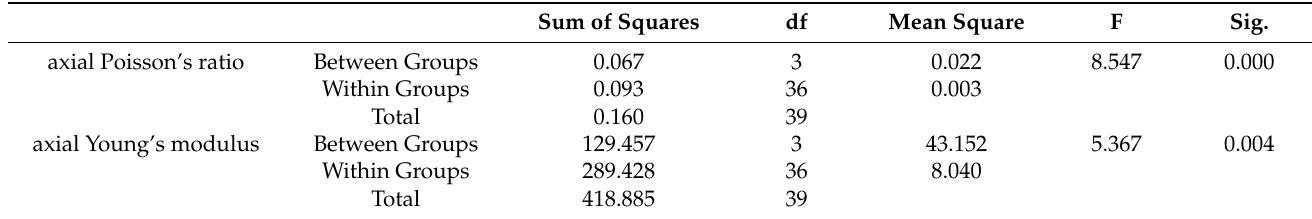
Table 3. The analysis of variances.